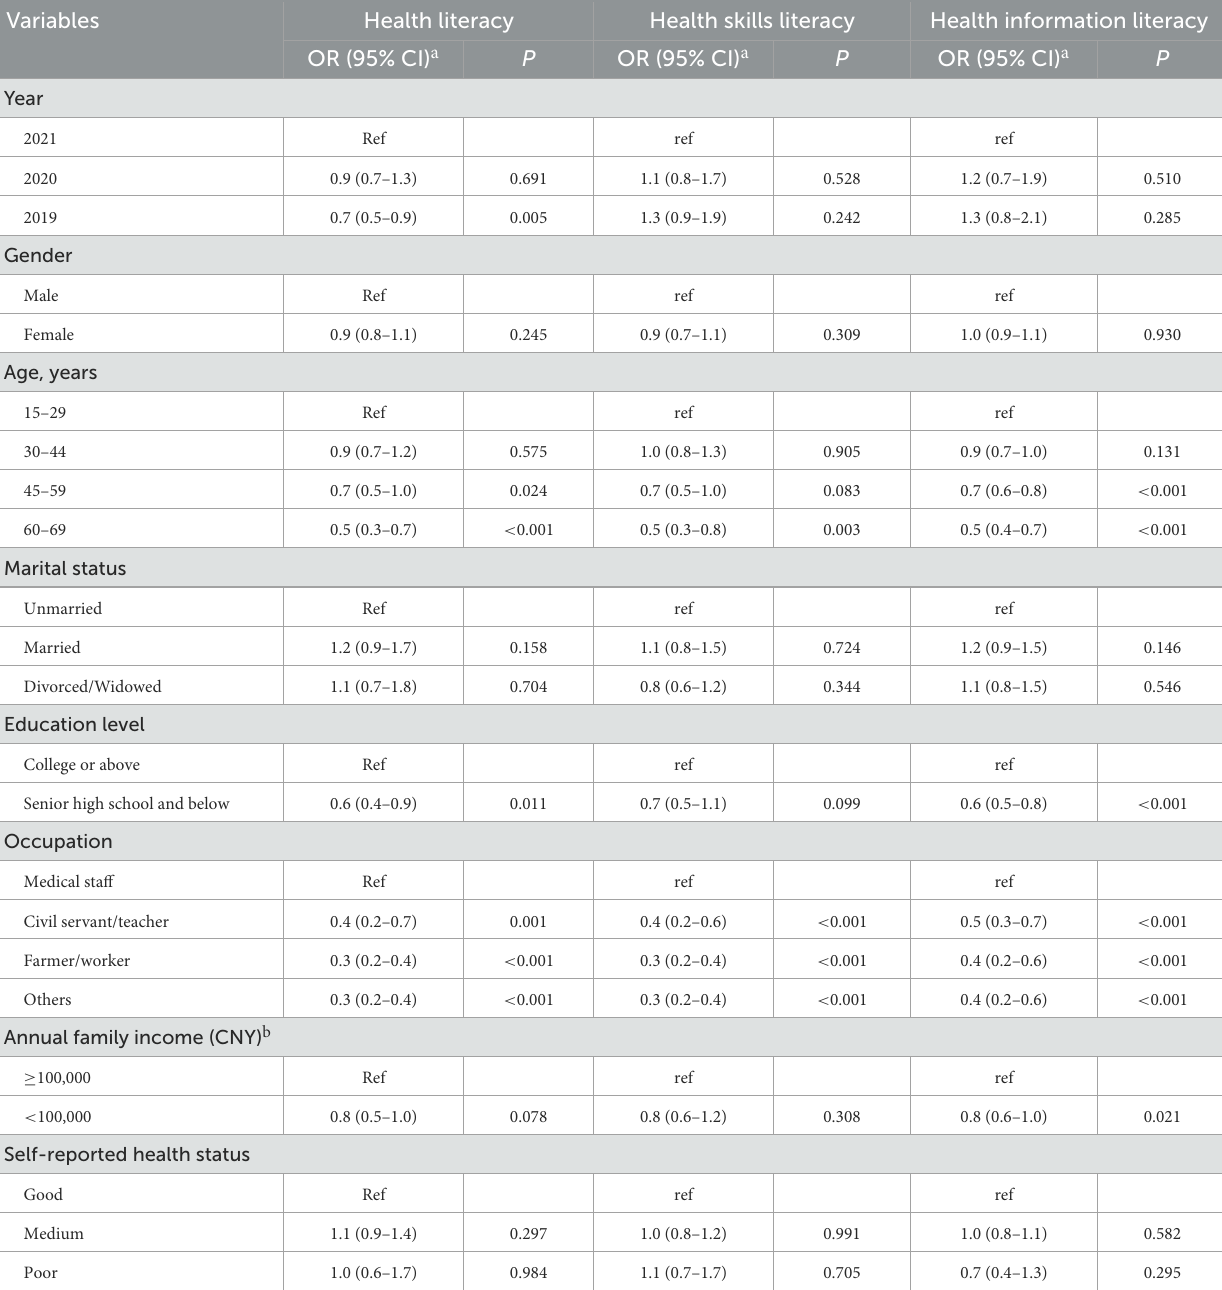
TABLE 4 Multivariable logistic regression analysis of factors related to health literacy, health skill literacy, and health information literacy